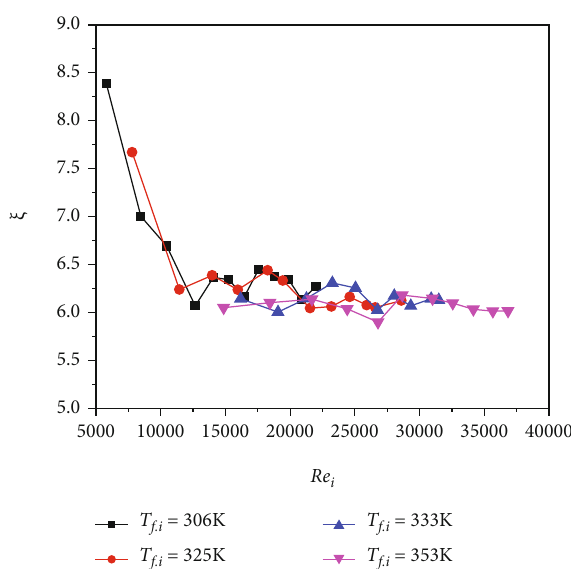
Figure 15: Variation of friction factor of main fuel path.